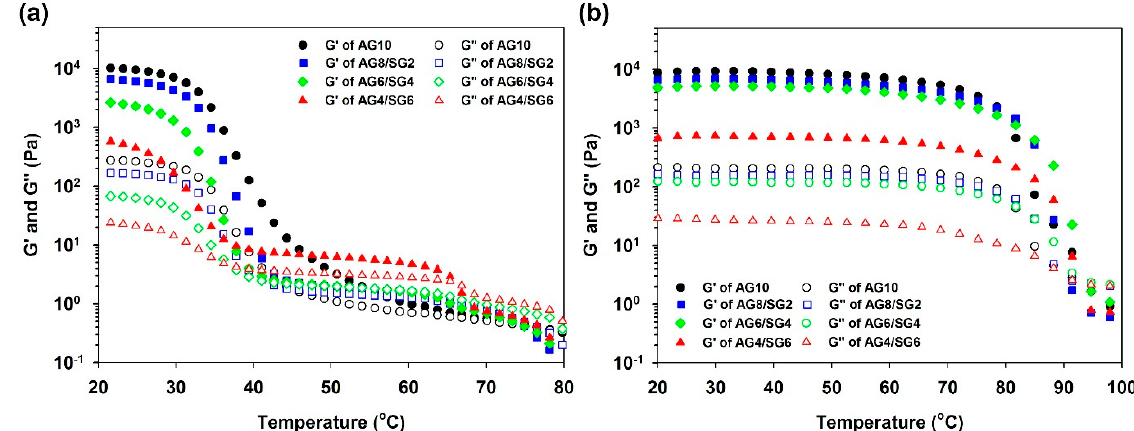
Figure 3. Temperature dependence of G’ and G” during ( a ) cooling and ( b ) heating process for agarose/succinoglycan hydrogels.